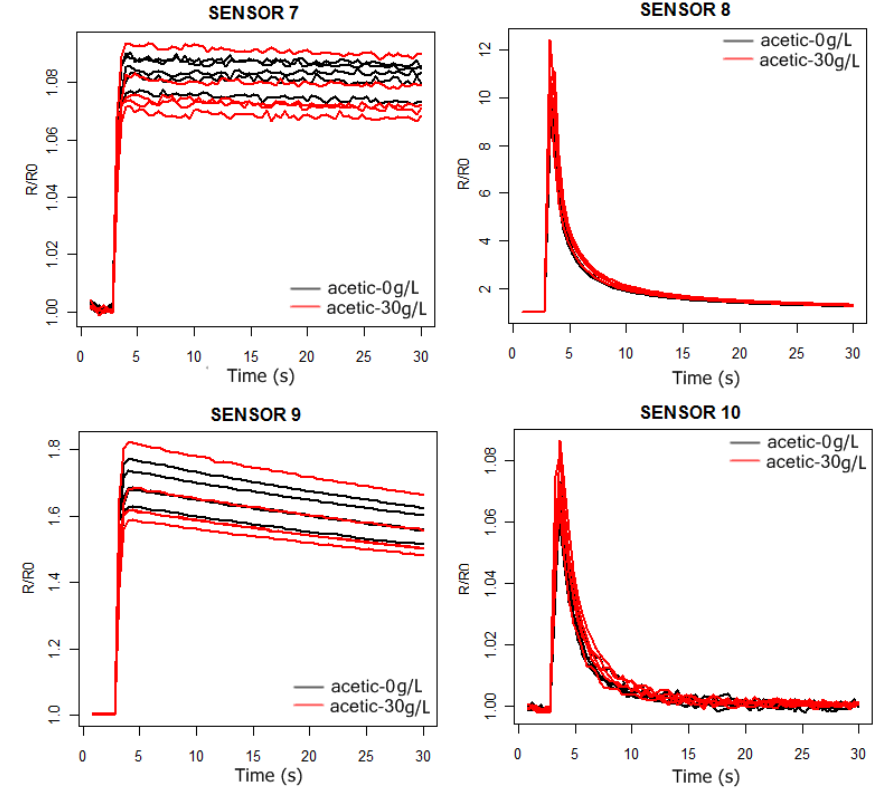
Figure 4. Sensor 7–10 response curves of the PEN3 electronic nose. Black: 10% aqueous ethanol solution. Red: 10% aqueous ethanol solution doped with acetic acid 30 g/L.